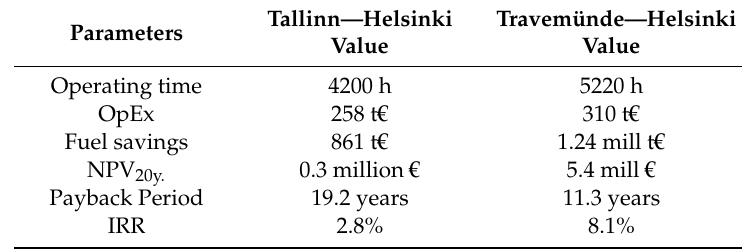
Table 5. Capital Budgeting for Tallinn—Helsinki and Travemünde– Helsinki